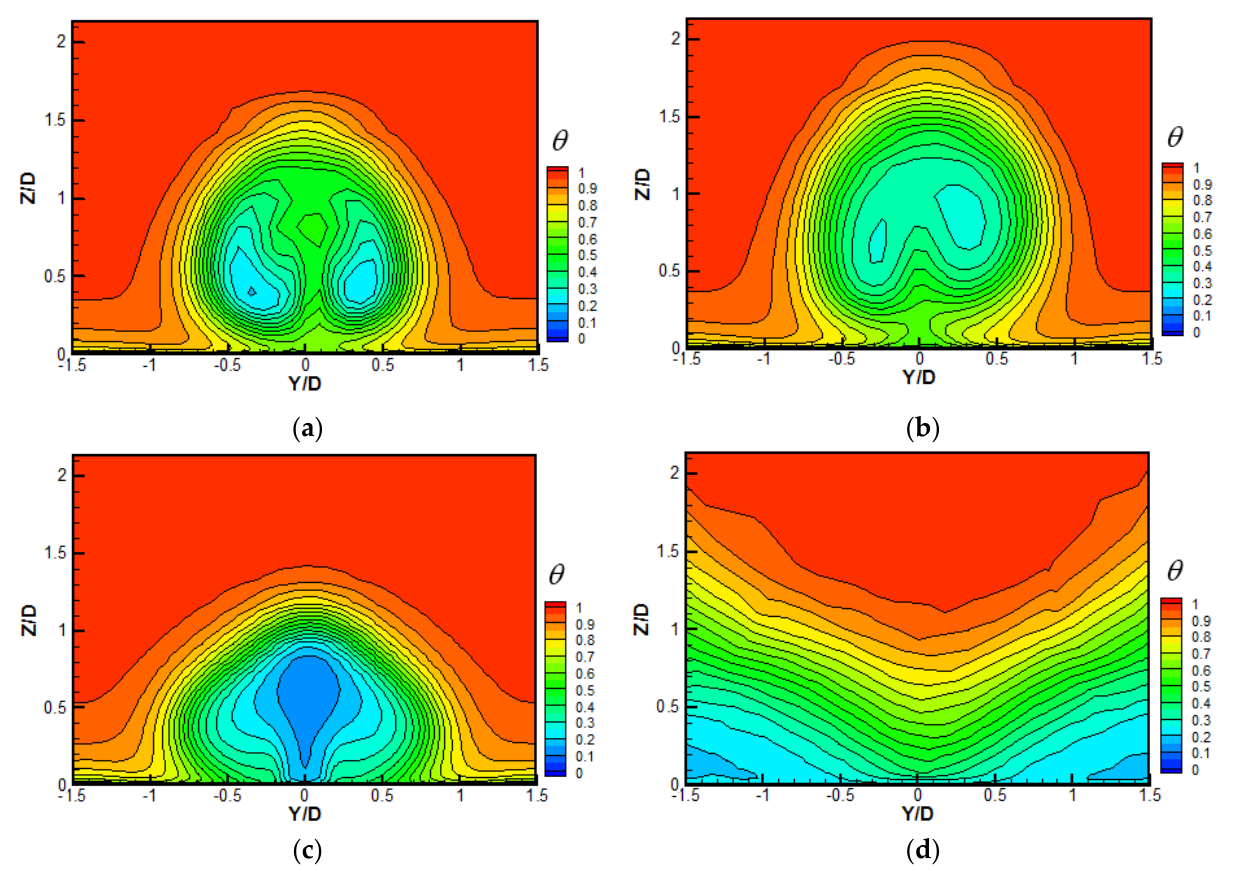
Figure 8. Contours of non-dimensional temperature over the surface X/D = 5 at M = 1.5. ( a ) CYL; ( b ) CIR_CRA; ( c ) CRA1; ( d ) CRA2.